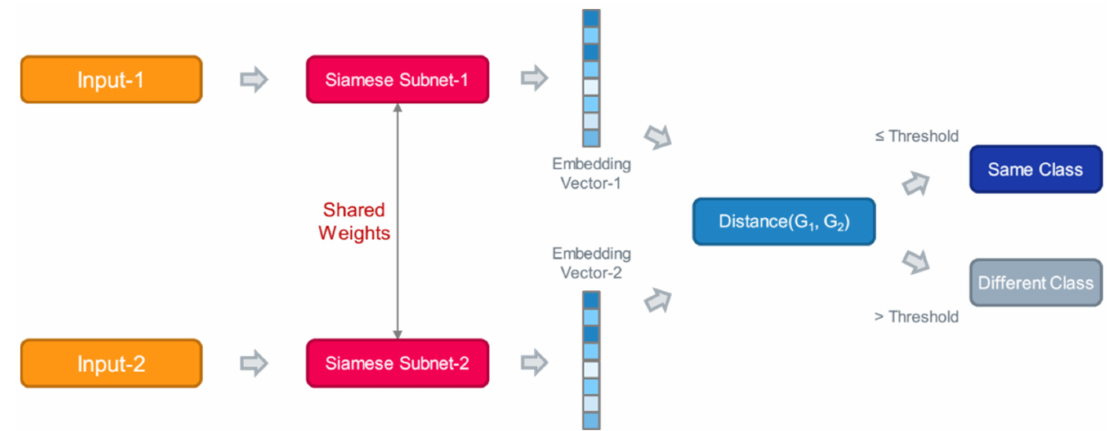
Figure 7. Siamese network